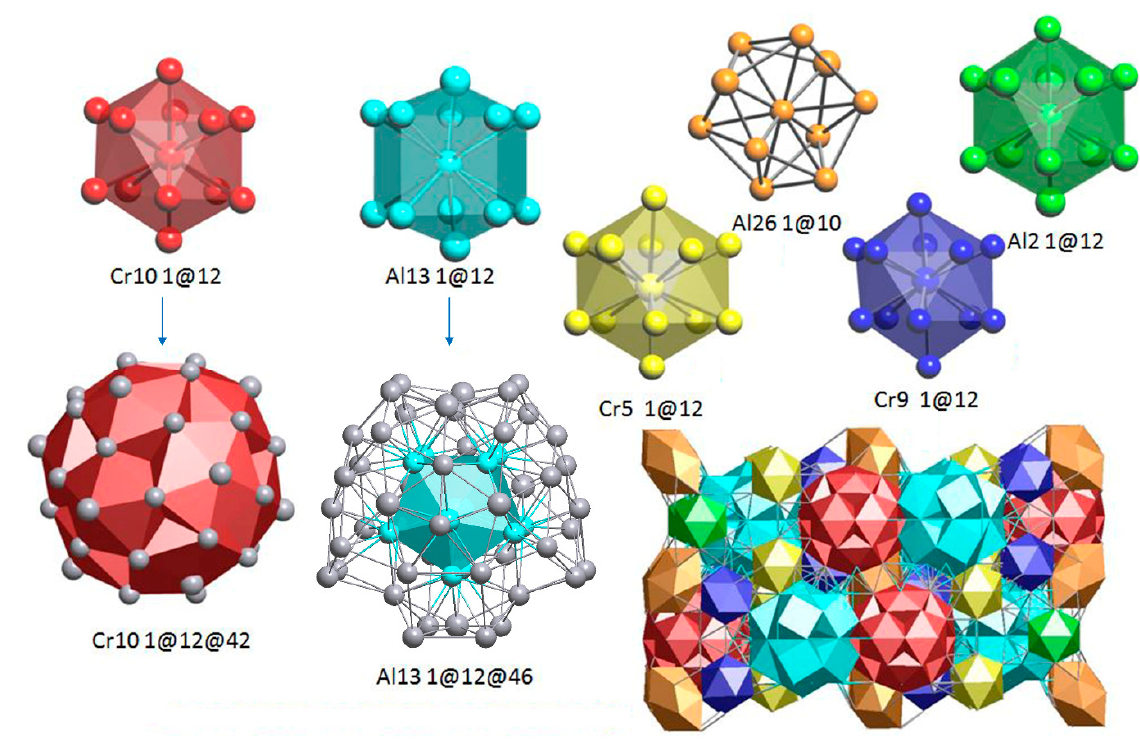
Figure 2. The entire unit cell of ε -Al 4 Cr structure composed of six cluster units.